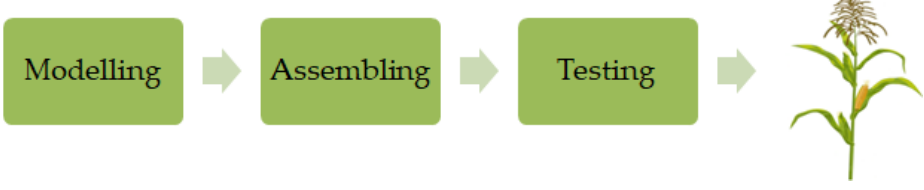
Figure 3. A simplified approach of design in silico .